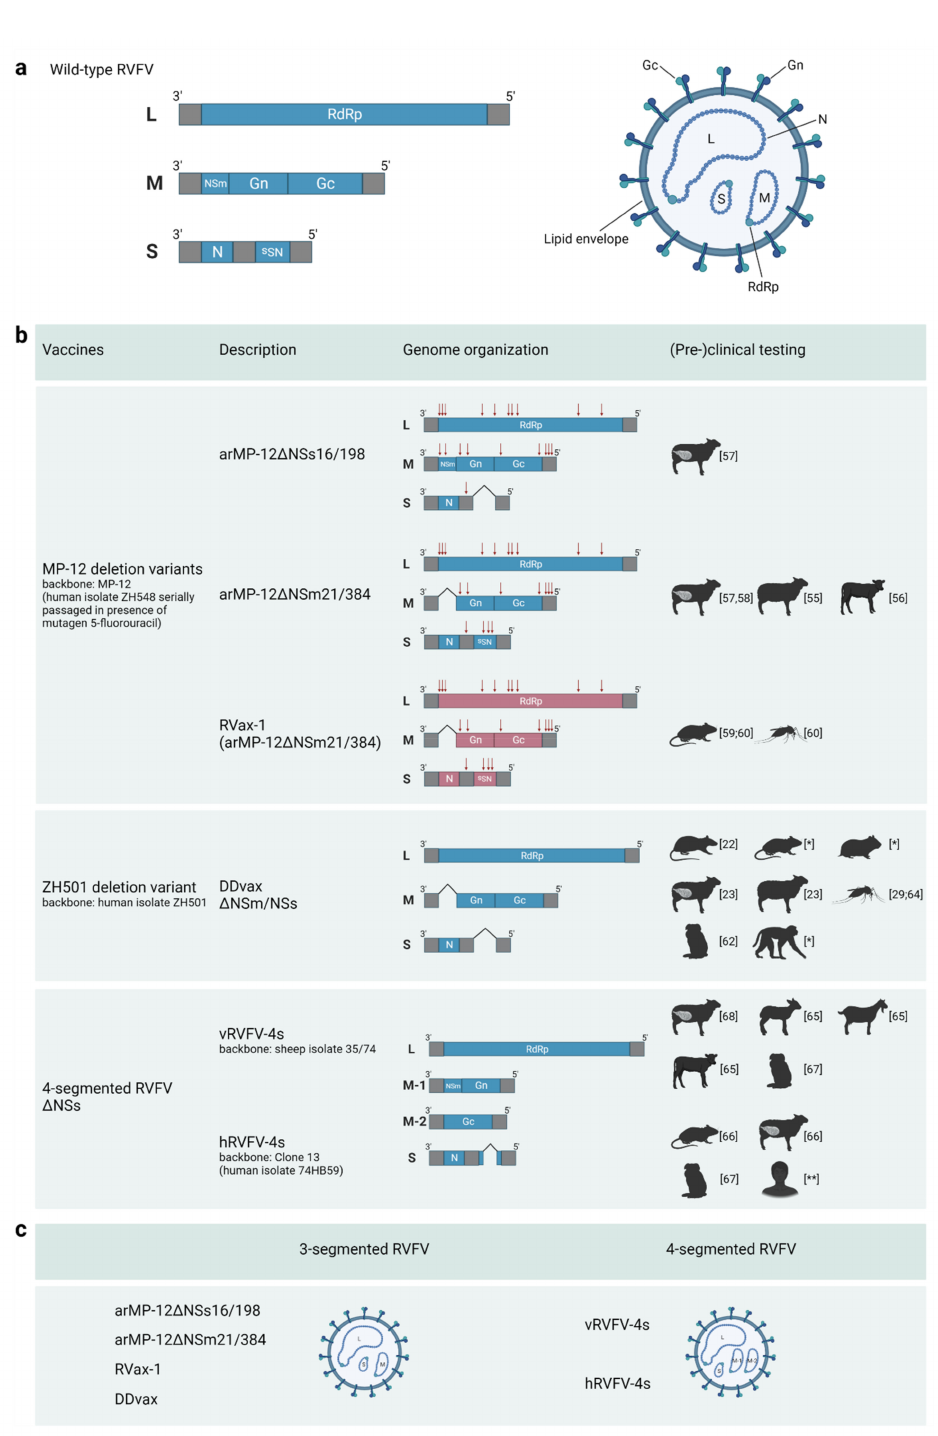
Figure 1. Schematic representation of the genome organization of wild-type RVFV and live-attenuated vaccine candidates currently being developed beyond the proof-of-concept phase. ( a ) Wild-type RVFV genome and virion. ( b ) Genome organization of a selection of live-attenuated RVF vaccine candidates. Red arrows indicate the location of point mutations in a particular genome segment, and red open reading frames in RVax-1 indicate the presence of silent mutations every 50 nucleotides. Species in which the safety and/or efficacy of the candidate vaccines have been evaluated are illustratively represented. * Manuscript in preparation, ** Ongoing trial. ( c ) Classification of live-attenuated RVF vaccine candidates as 3- or 4-segmented